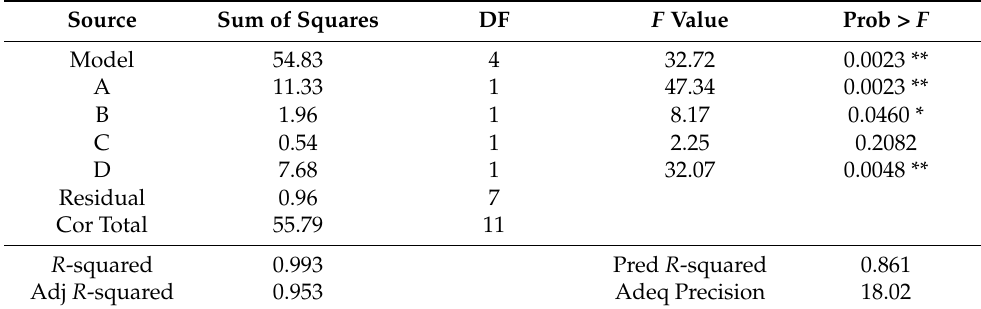
Table 6. Analysis of variance (ANOVA) for Plackett-Burman design for biosurfactant production using PCO as a substrate.